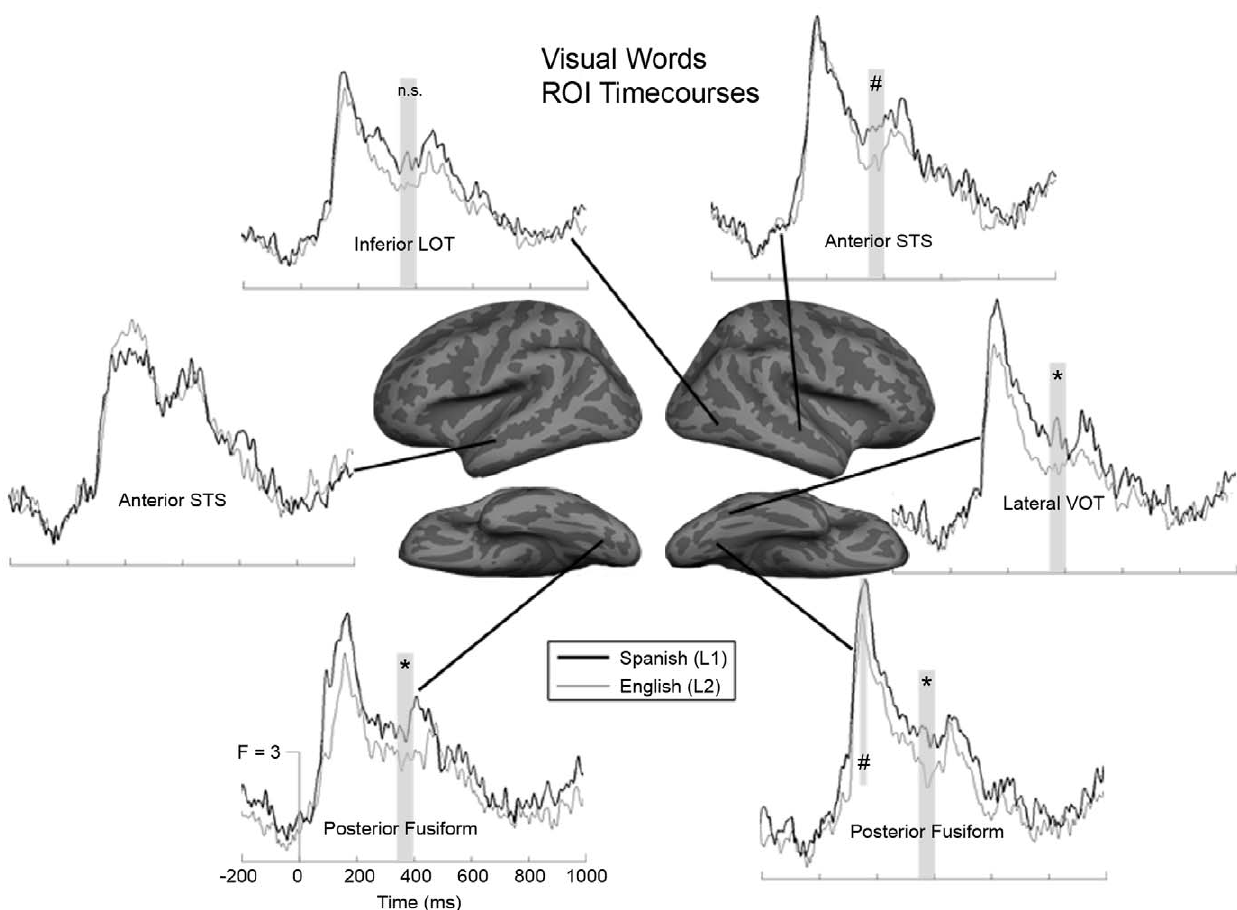
Figure 3. Average time courses for selected ROIs to new visual words. Several regions show significant (denoted by *) or marginal (denoted by # ) Spanish (thick lines) . English (thin lines) effects during the early (150–190 ms) and late (350–400 ms) time windows (gray bars). Responses appear generally greater over an extended time period for Spanish than for English, especially in right hemisphere and posterior areas.